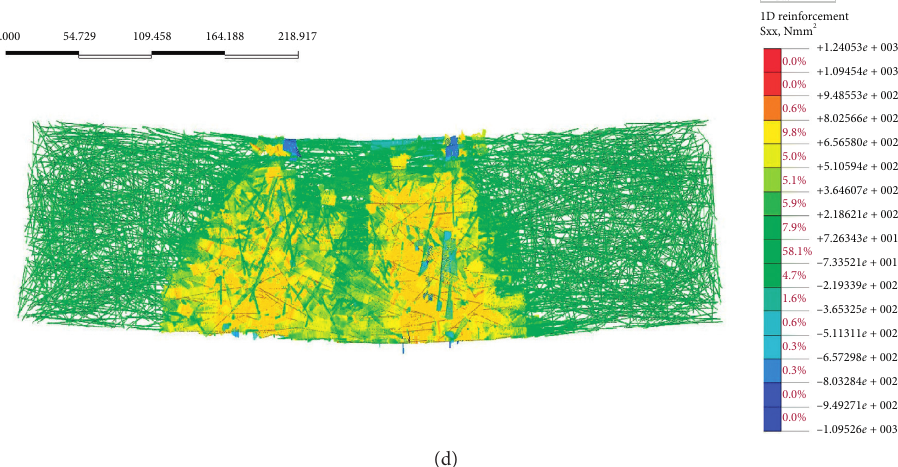
Figure 10: Steel fibre stress of M_1 beam (unit: MPa). (a) Point a . (b) Point b . (c) Point c. (d) Point d